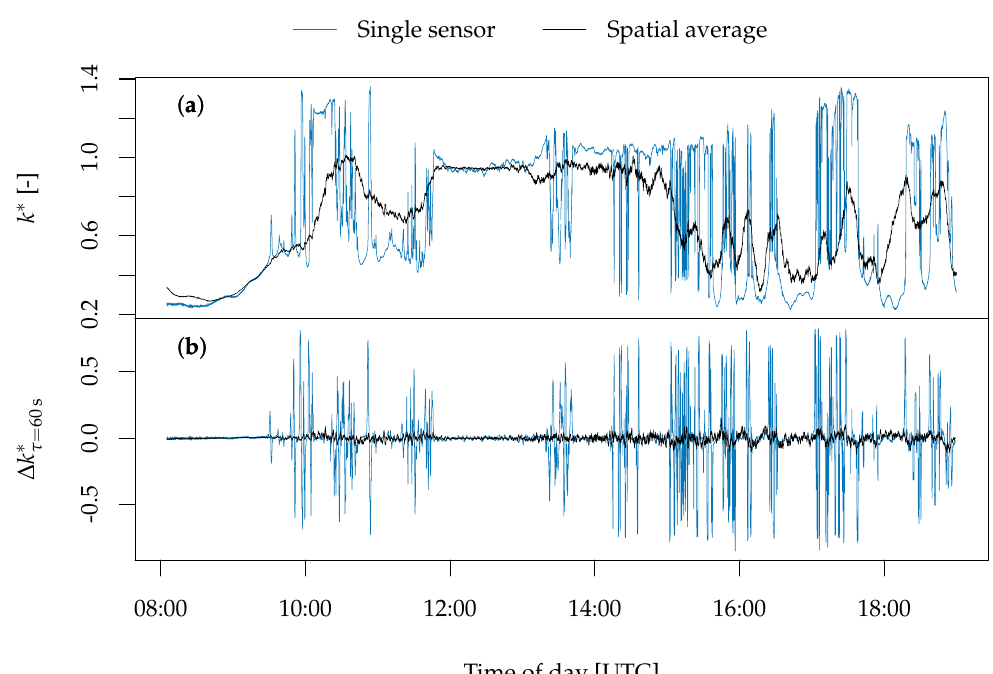
Figure 6. An example of spatial averaging: ( a ) the same 1s single-sensor clear-sky index k ∗ time series as in Figure 1 along with a corresponding spatially averaged 1s clear-sky index computed over as many as 99 pyranometers dispersed over an area of about 80km 2 ; ( b ) 1min clear-sky index increments ∆ k ∗ τ derived according to Equation (5) for both the single-sensor time series and the spatial average. The underlying irradiance data were collected during the HOPE campaign